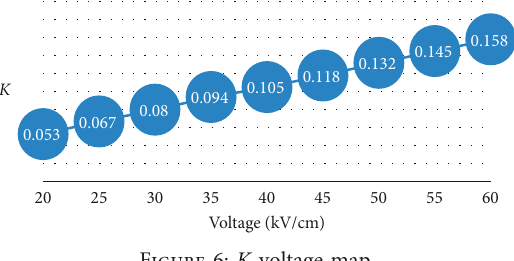
Figure 6: K -voltage map.